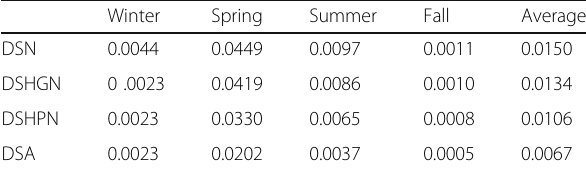
Table 4 Daily prediction error variance Winter Spring Summer